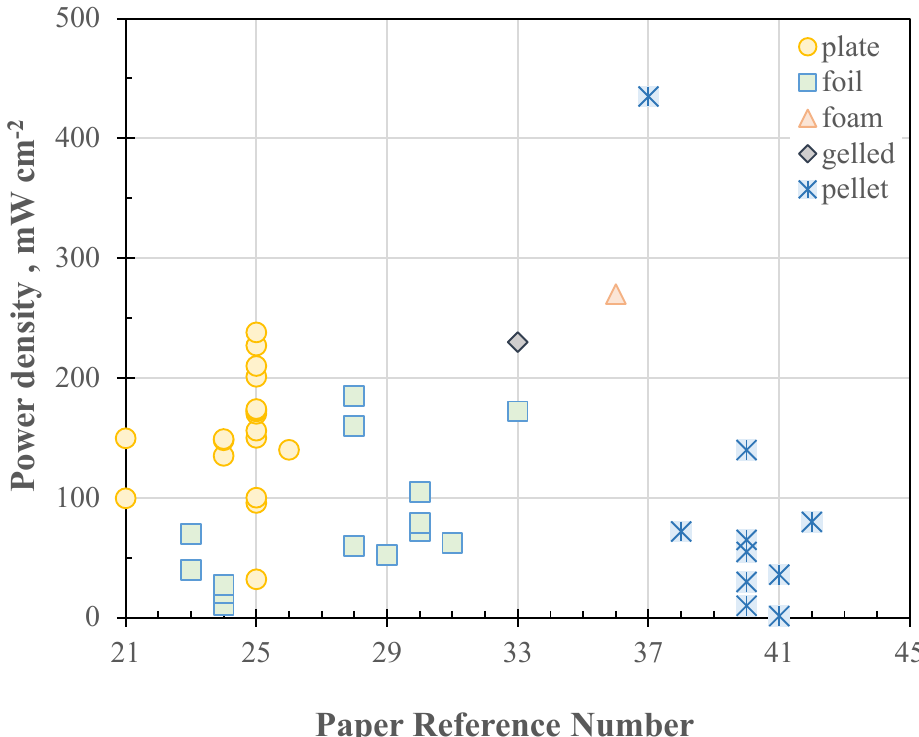
Figure 2. Power density of Zn-air battery as reported in various papers [24–45]. Zinc plate and foil were commonly employed in the laboratory investigations.